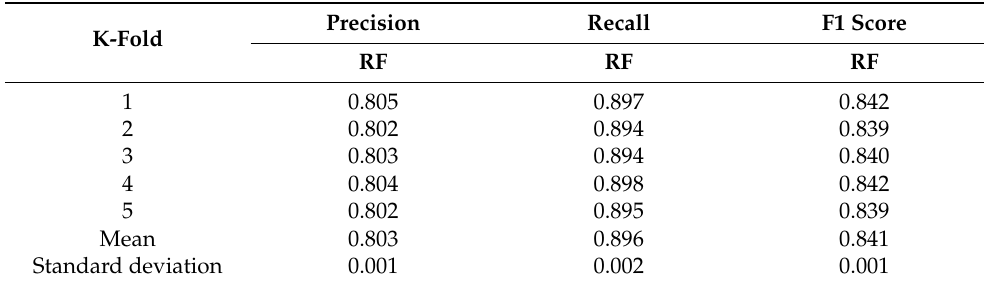
Table 2. Efficiency indicators of the cross-validations for each bioclimatic model using the training data (80% of the current map).